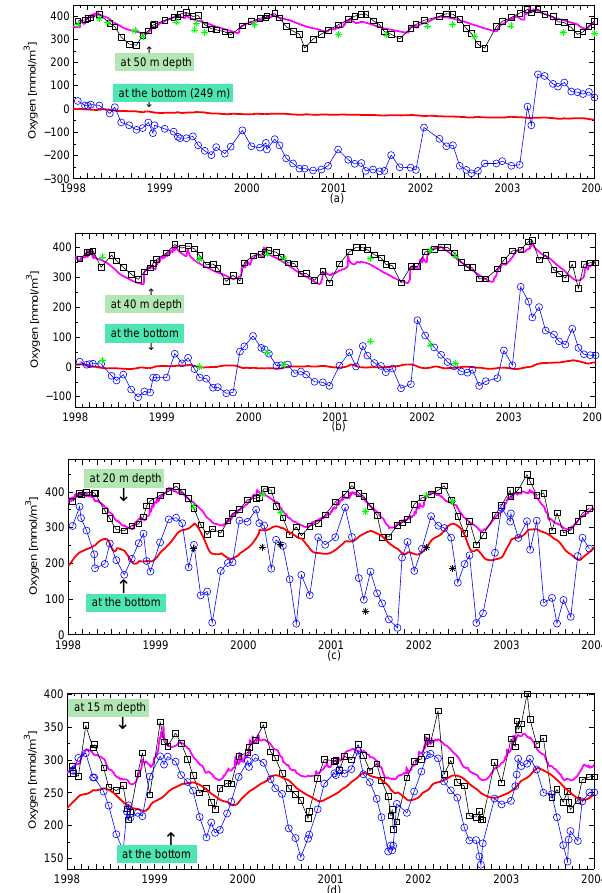
Fig. 9. Oxygen time series in the intermediate and bottom layer for a six year period. Calculated results are presented with a thick solid line: magenta colour (intermediate); red colour (bottom). BED data is denoted by black squares (intermediate) connected with a thin line and blue circles (bottom) connected with a thin line. FIMR data is presented with green asterisks. (a) – at GS; (b) – at BS; (c) – at AS; (d) – at